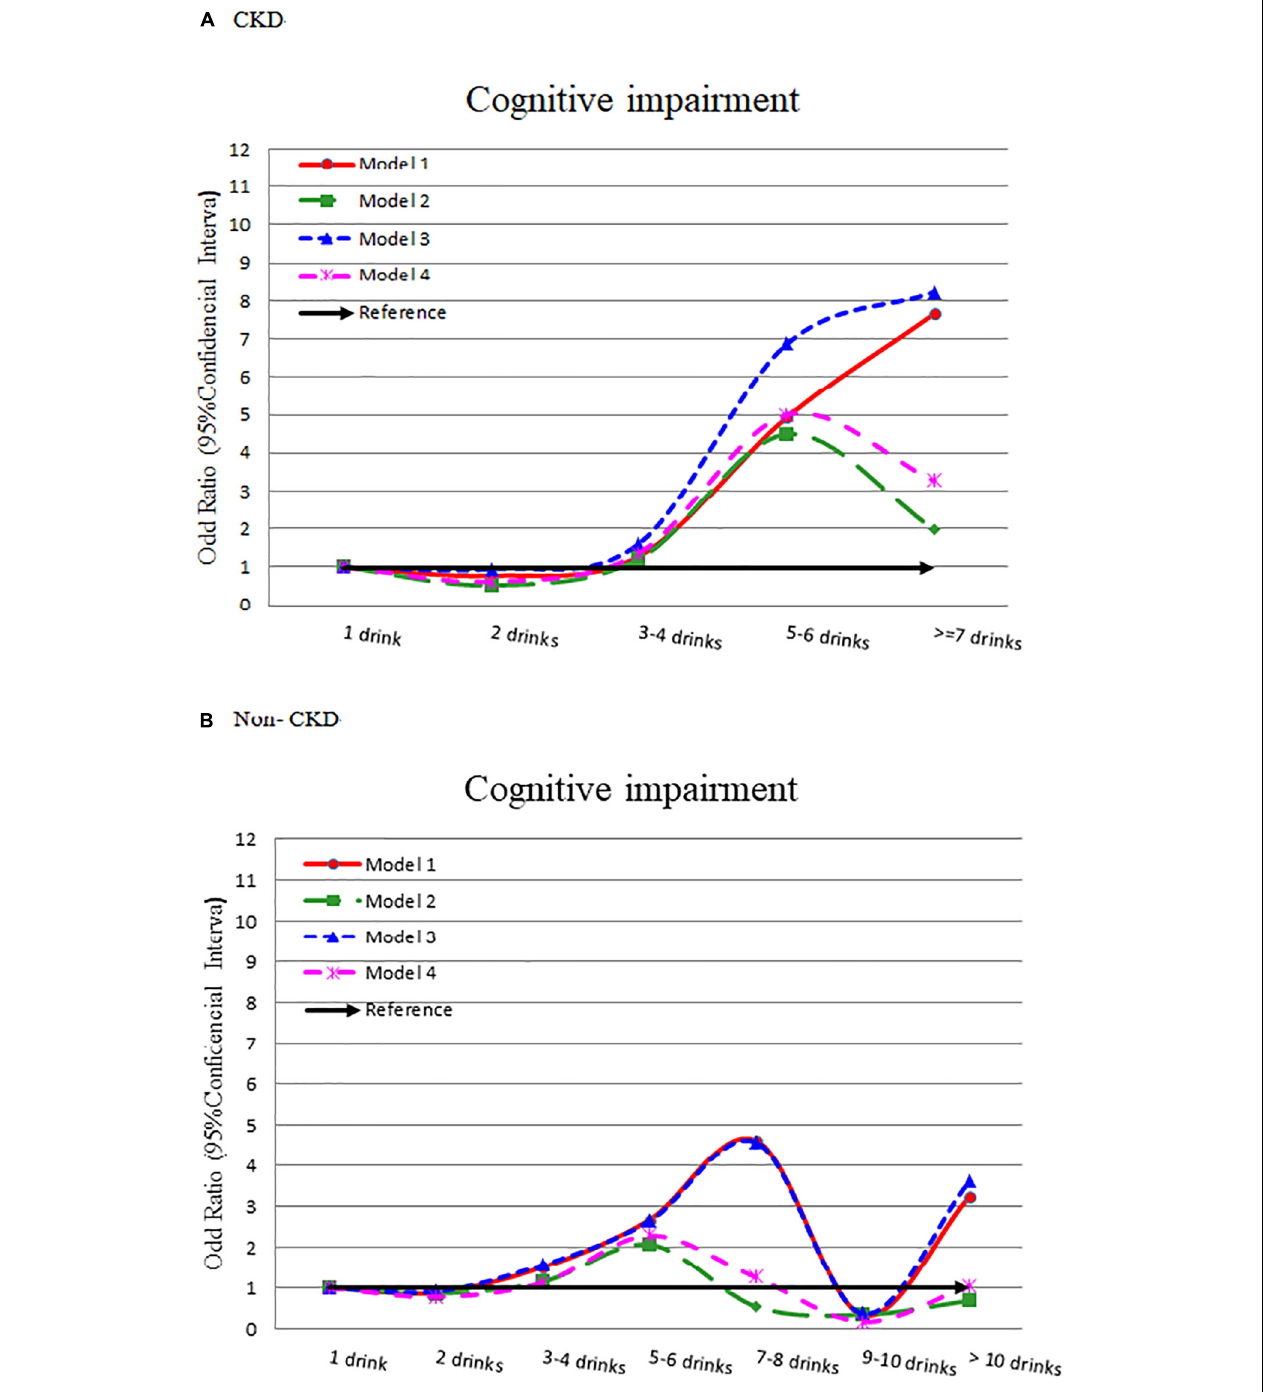
FIGURE 3 | Odds ratio for cognitive impairment by different alcohol consumption categories-stratified by CKD. (A) With CKD and (B) without CKD. Model 1: crude OR (95%CI). Model 2: adjusted for demographic variables. Model 3: adjusted for comorbidity variables. Model 4: adjusted for all significant variables in Supplementary Table 6